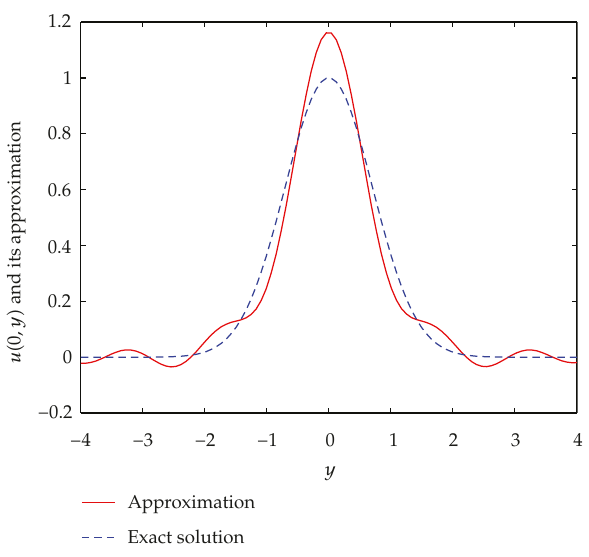
Figure 4: x (cid:2) 0 , δ (cid:2) 1 ∗ 10 − 2 , ξ c (cid:2) 4 . 45